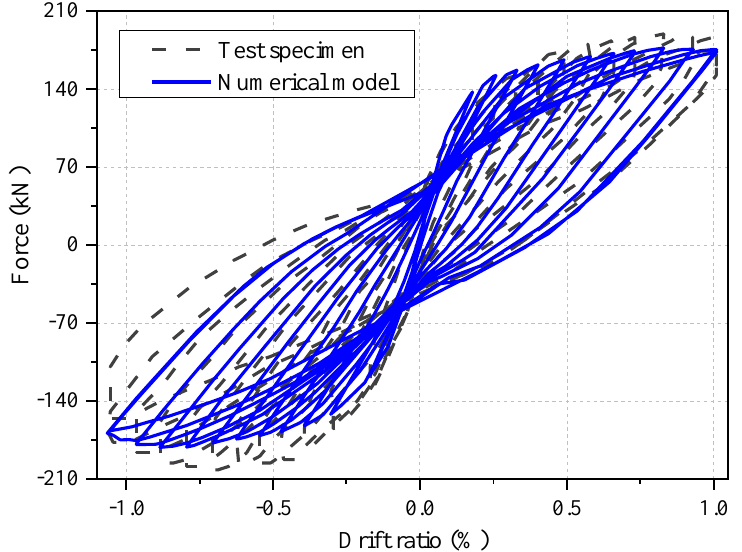
Figure 7. Hysteretic curves of the prototype specimen [26].